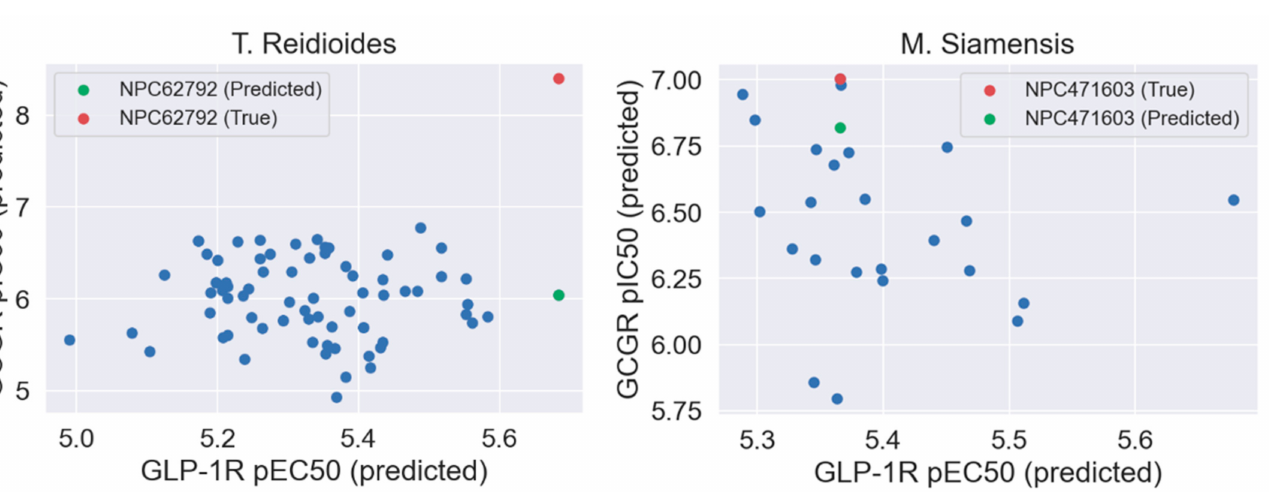
Figure 7. Evaluation of CMAUP-derived compounds using our GCGR and GLP-1R models.